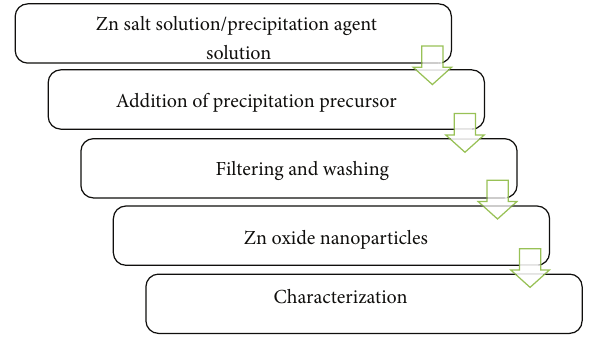
Figure 2: Precipitation